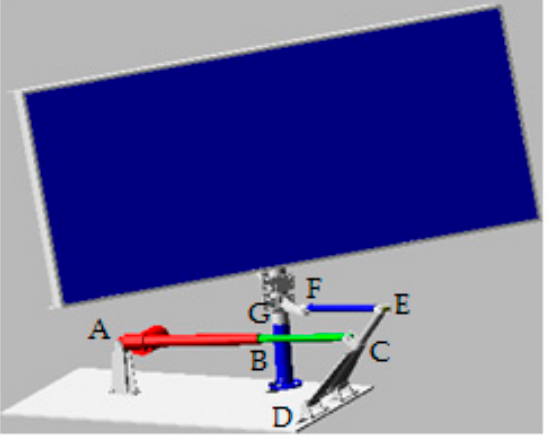
Figure 2. Azimuthal tracking system with spatial four-bar linkage.